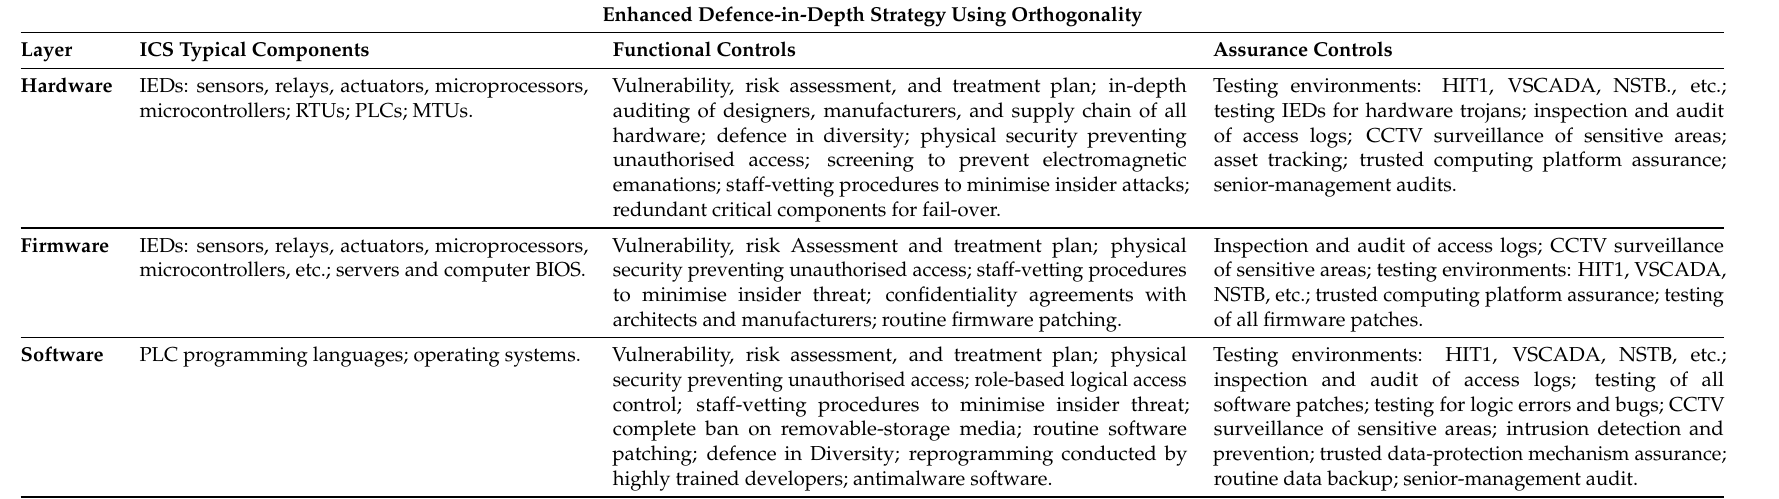
Table 4. Applying orthogonality to enhance ICS defence-in-depth strategy